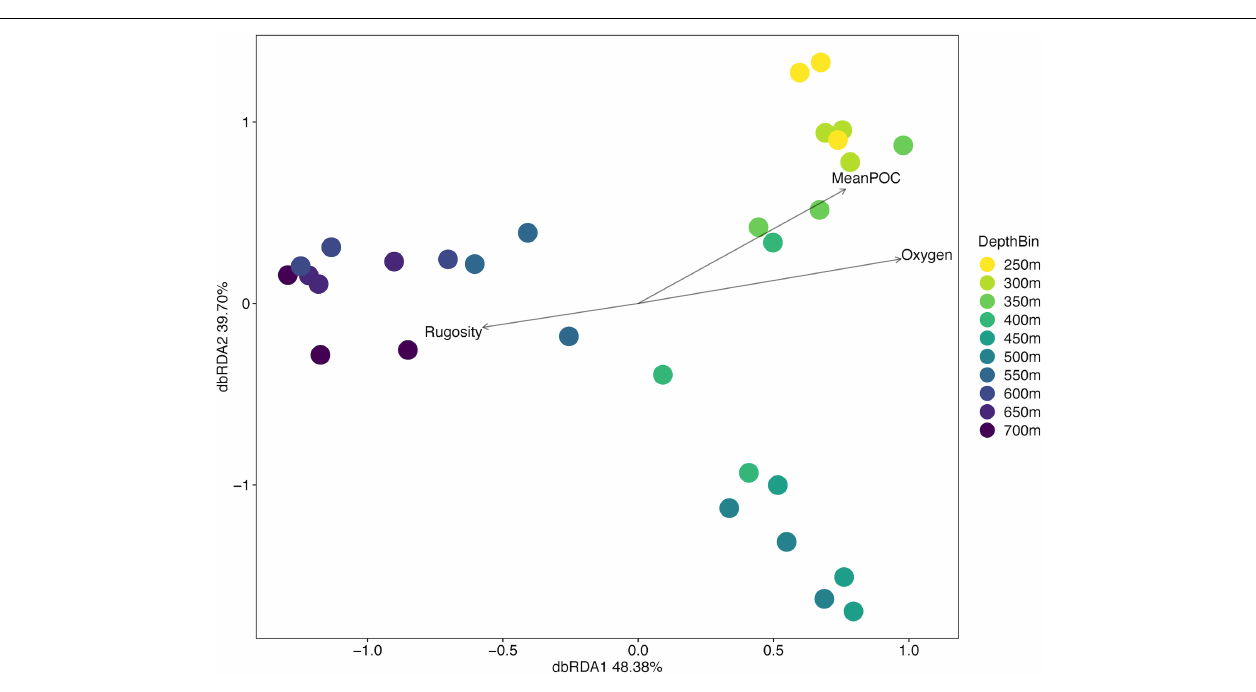
( Table 1 ). In general, shallow transects had higher POC and oxygen concentrations and lower rugosity than deep